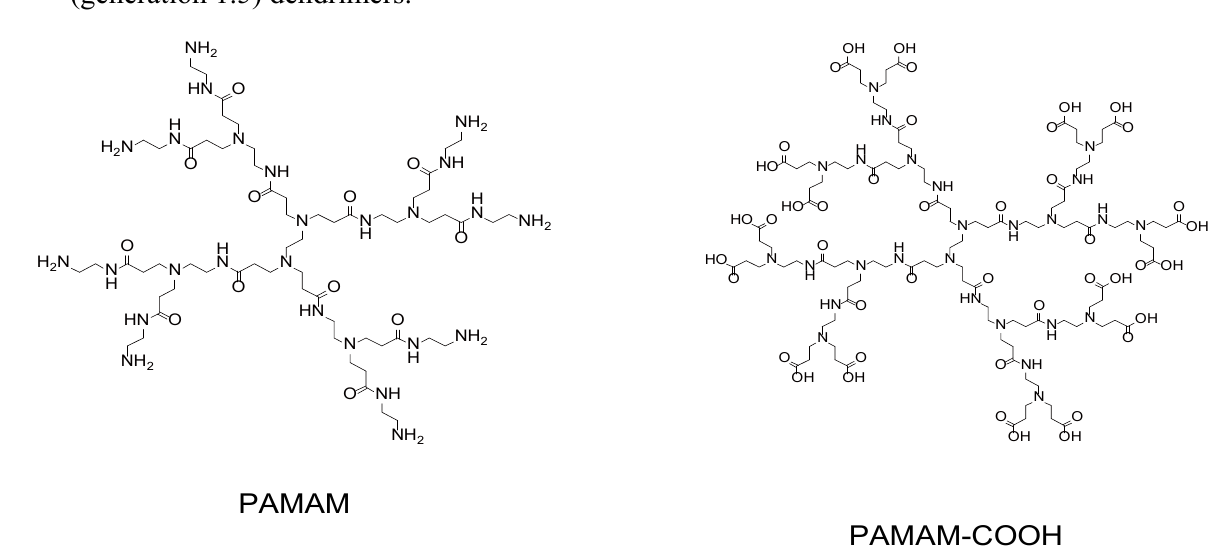
Figure 1. Chemical structures of PAMAM (generation 1) and PAMAM–COOH (generation 1.5)